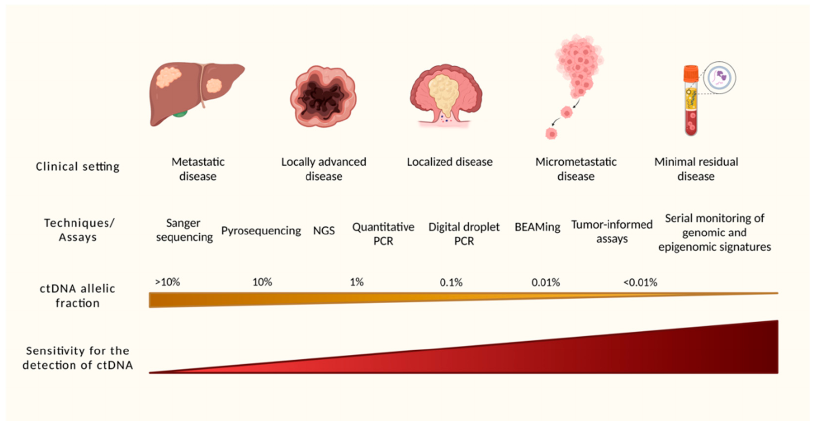
Figure 2. Techniques and assays for detection of ctDNA. The sensitivity of the molecular techniques has increased in recent years for the identification of small allelic fractions of ctDNA. The development of tumor-informed assays and association of epigenomic signatures have allowed detection of allelic fractions lower than 0.01% and with high specificity. Created with Biorender.com. Abbreviations: NGS: next-generation sequencing, PCR: polymerase chain reaction